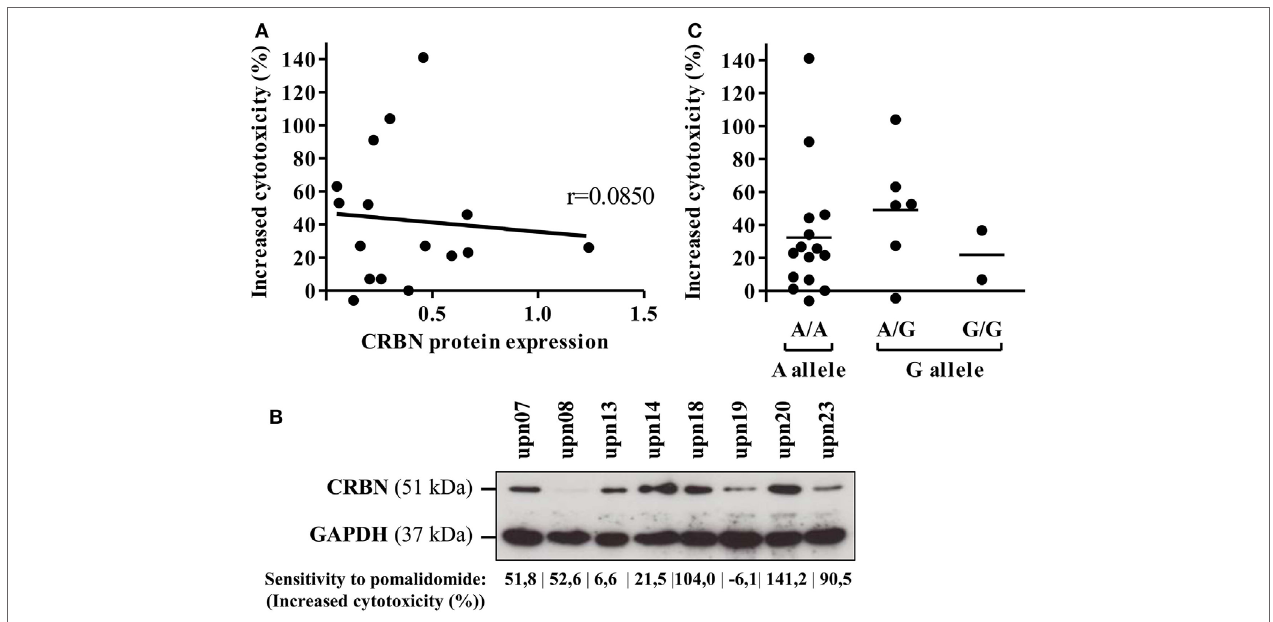
FigUre 6 | Cereblon (CRBN) mRNA, protein levels, and polymorphism do not correlate in acute myeloid leukemia (AML) samples with different sensitivity to pomalidomide. Primary AML blasts express CRBN irrespectively of their sensitivity to pomalidomide. (a) Linear regression of the AML blast sensitivity to pomalidomide (increased cytotoxicity by allogeneic natural killer cell) and CRBN protein expression (normalized to GAPDH) evaluated by western blot ( n = 16). Correlation was established using Pearson’s correlation coefficient. (B) Western blot analysis of total protein extracts from primary AML blasts poorly or well sensitized by pomalidomide. (c) Genotyping analysis for A/G CRBN polymorphism for primary AML cells ( n =